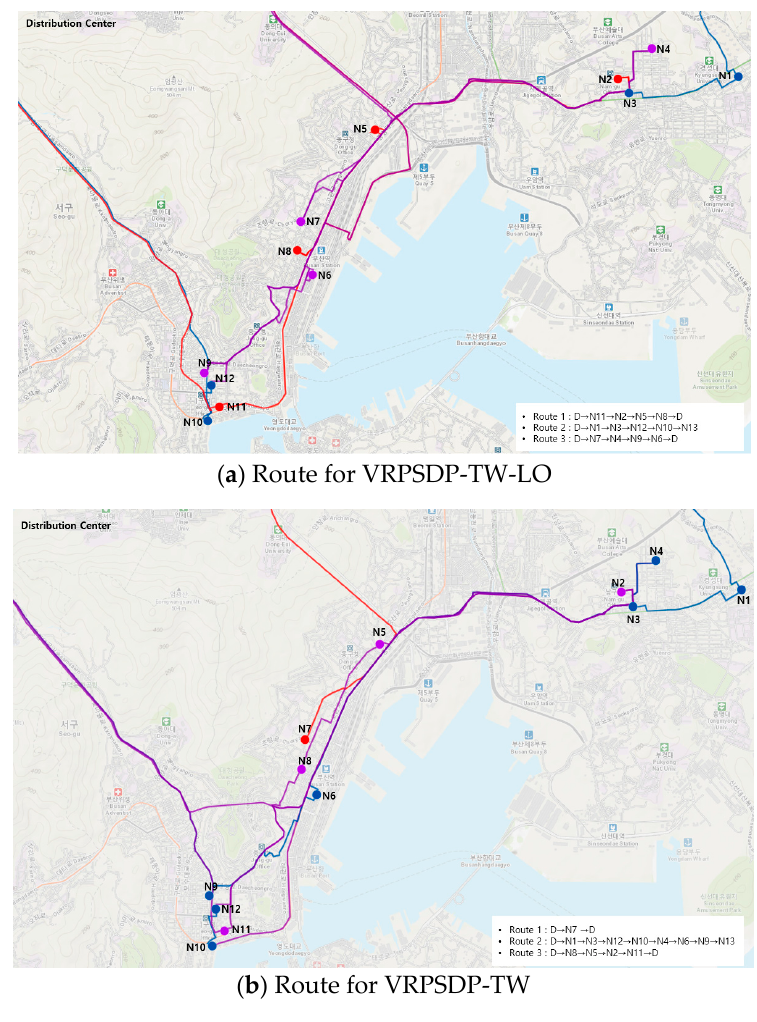
Figure 3. Example of different routes for VRPSDP-TW and VRPSDP-TW-LO.